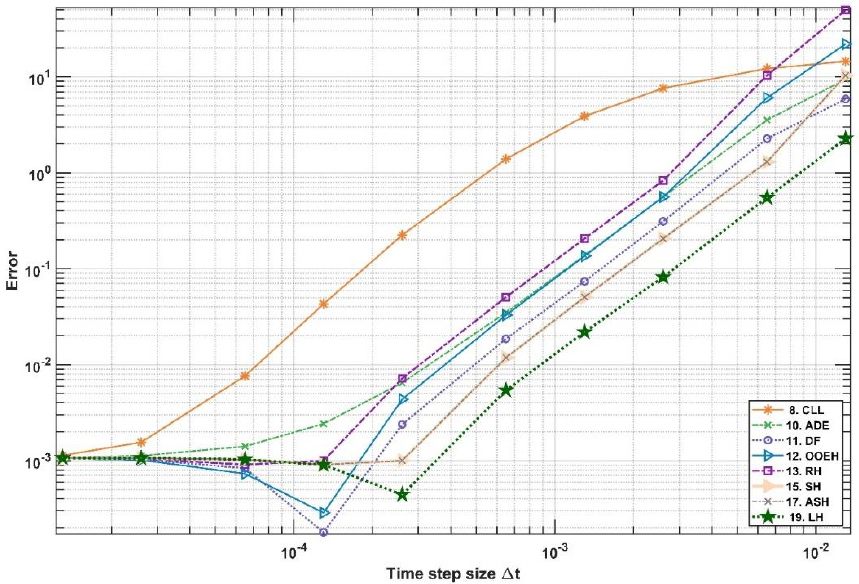
Figure 3. The errors as a function of the time step size for the quickly converging methods, as well as the CLL method in the case of Experiment 1. The error curves reach the residual error τ 0 on the left side of the figure.